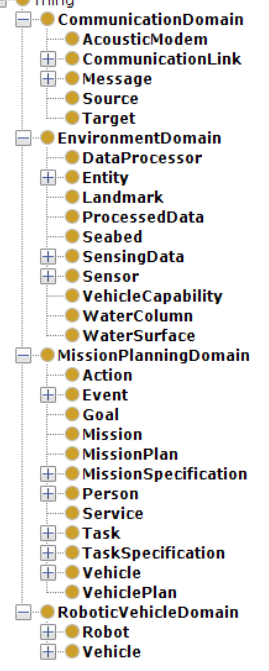
Figure 9. A snapshot of the hierarchy of the SWARMs ontology.